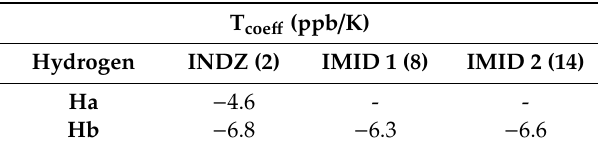
Table 6. Temperature coefficients (T coeff ) obtained for N-Ha proton of compound 2 and N-Hb protons of compounds 2 , 8 , and 14 .